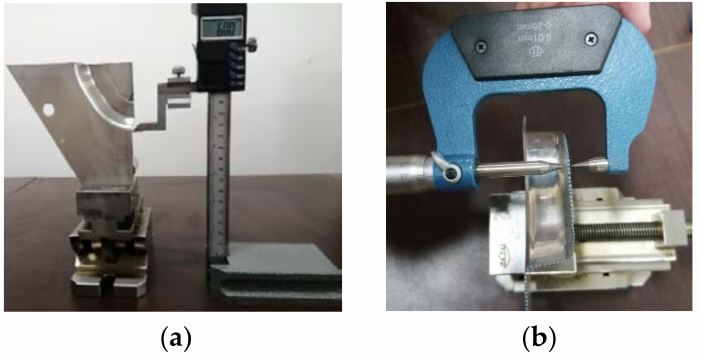
Figure 24. Thickness measurement: ( a ) sample point marking and ( b ) thickness